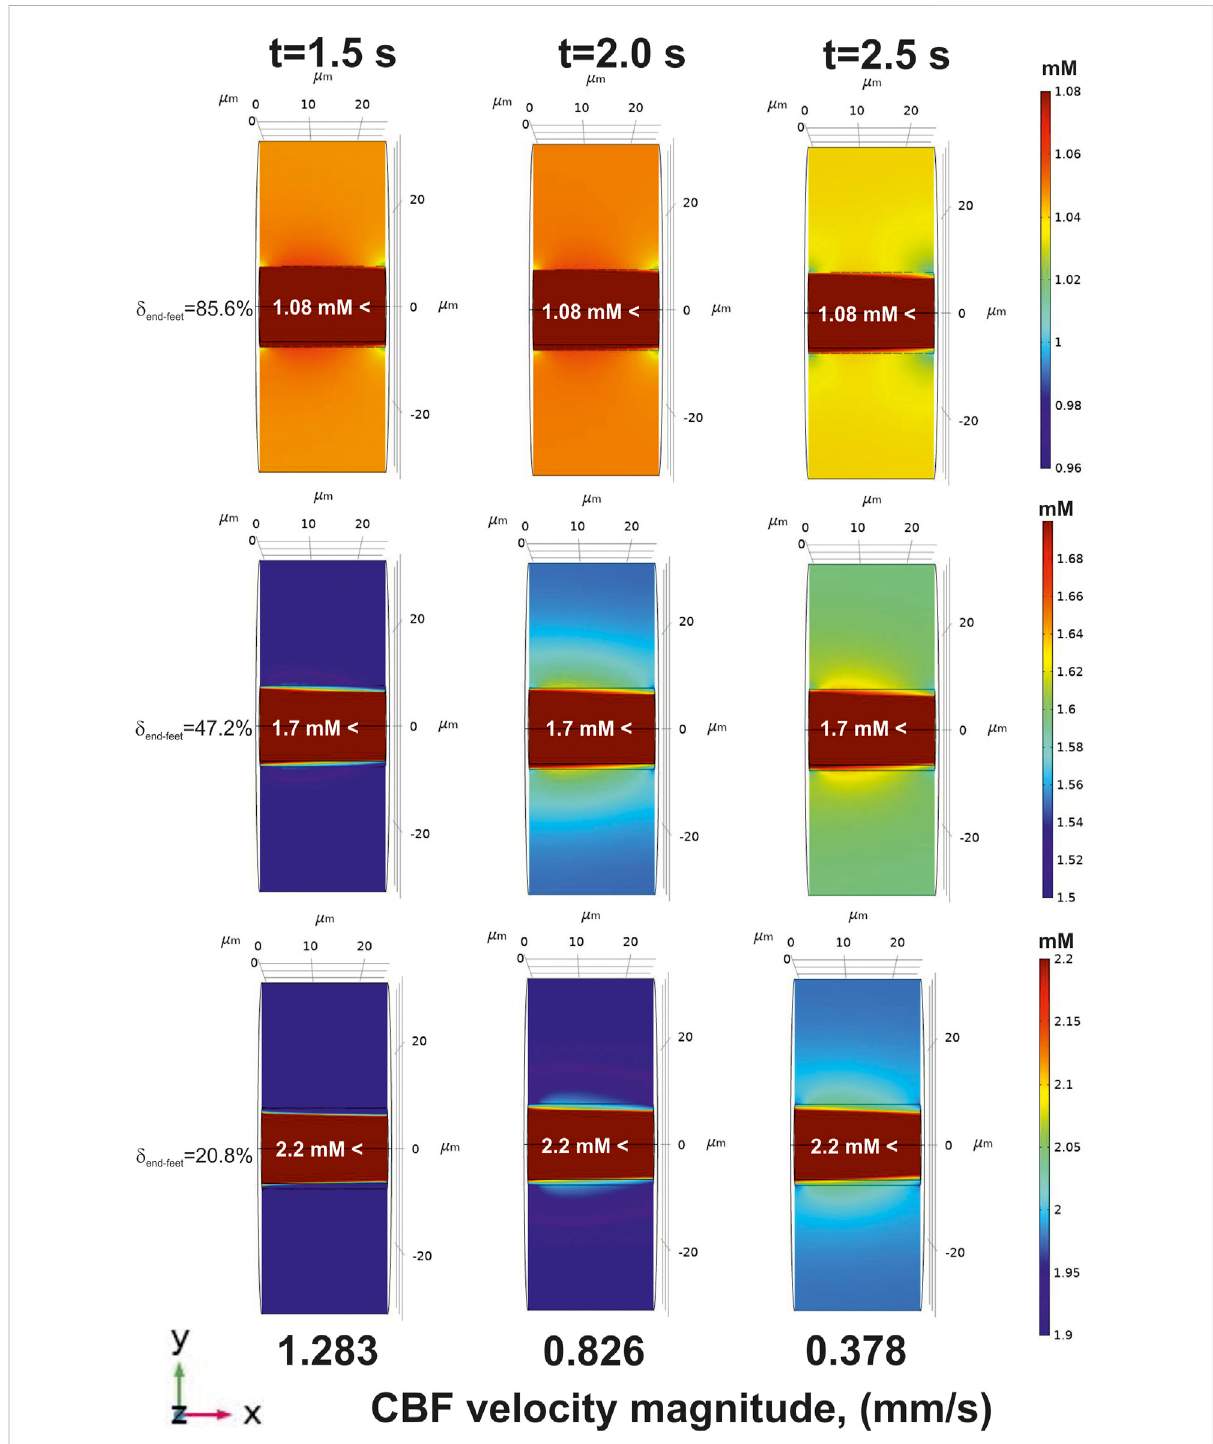
FIGURE 6 Theglucosegradientsnear ablood capillary surfaceafter CBFdecrease(anapplicationof f dec shift ( t ) to thepressureon theend transverse surfaces S ′ z Ω S ″ z Ω I and I ). The concentrations are represented in the central longitudinal cut plain XY at the three moments of time (indicated in the top). The corresponding CBF velocity magnitudes are speci fi ed in the bottom. For clear visualization the different glucose concentration scales are chosen in each case. The lumen of blood capillary ( Ω I ) has a separate distribution of glucose formed by reaction-diffusion and convection. Due to a narrow range of scale, it is fi lled with a single color and a numerical indication. The glucose gradients represented for 85.6%, 47.2%, and 20.8% of δ end − feet